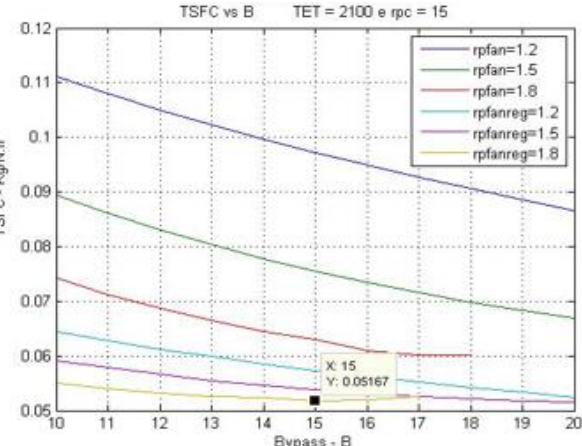
Figure 10: TSFC vs BPR with and without regeneration (TET 2100K and rpc 15).